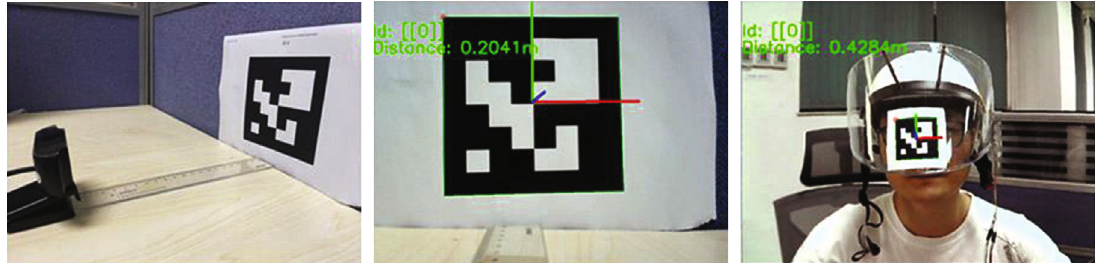
Figure 7: ArUco detection in the lab environment. Left: the camera is about 20cm away from the ArUco marker. Middle: after calibration, the camera can accurately detect the posture of the ArUco marker. Right: an ArUco marker is detected to determine the head posture relative to the screen.